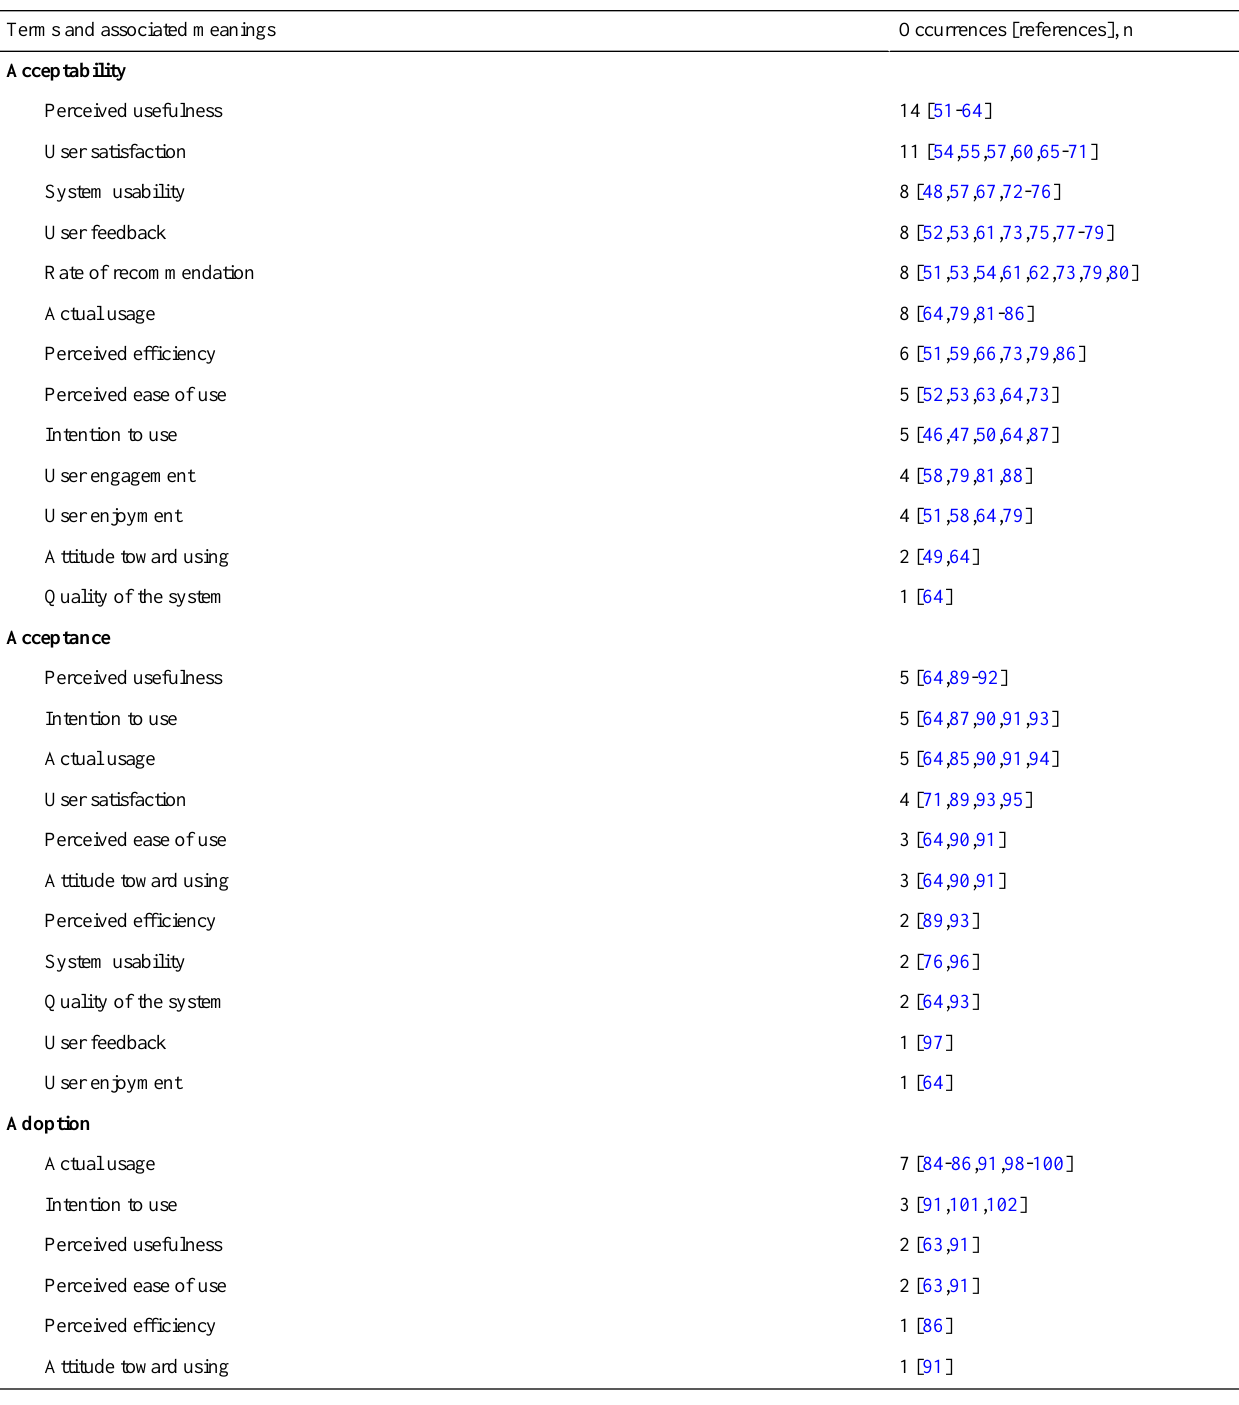
Table 2. Meanings associated with terminology (some studies referred to several concepts).